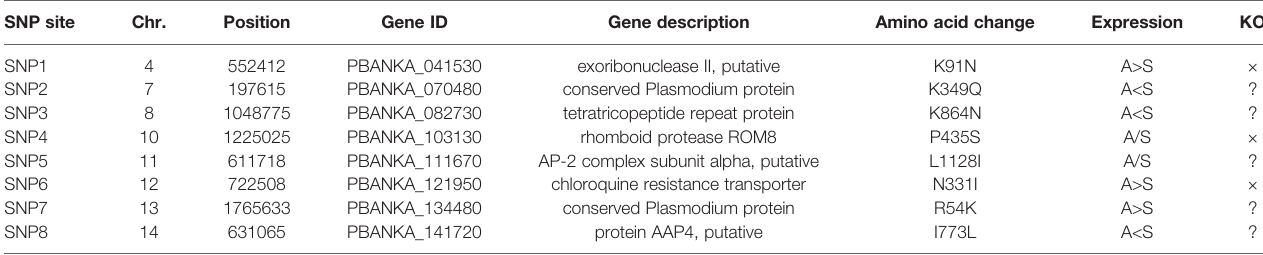
TABLE 1 | Eight SNPs conserved in 4 clones of PbMut-PPQ-R-P9.